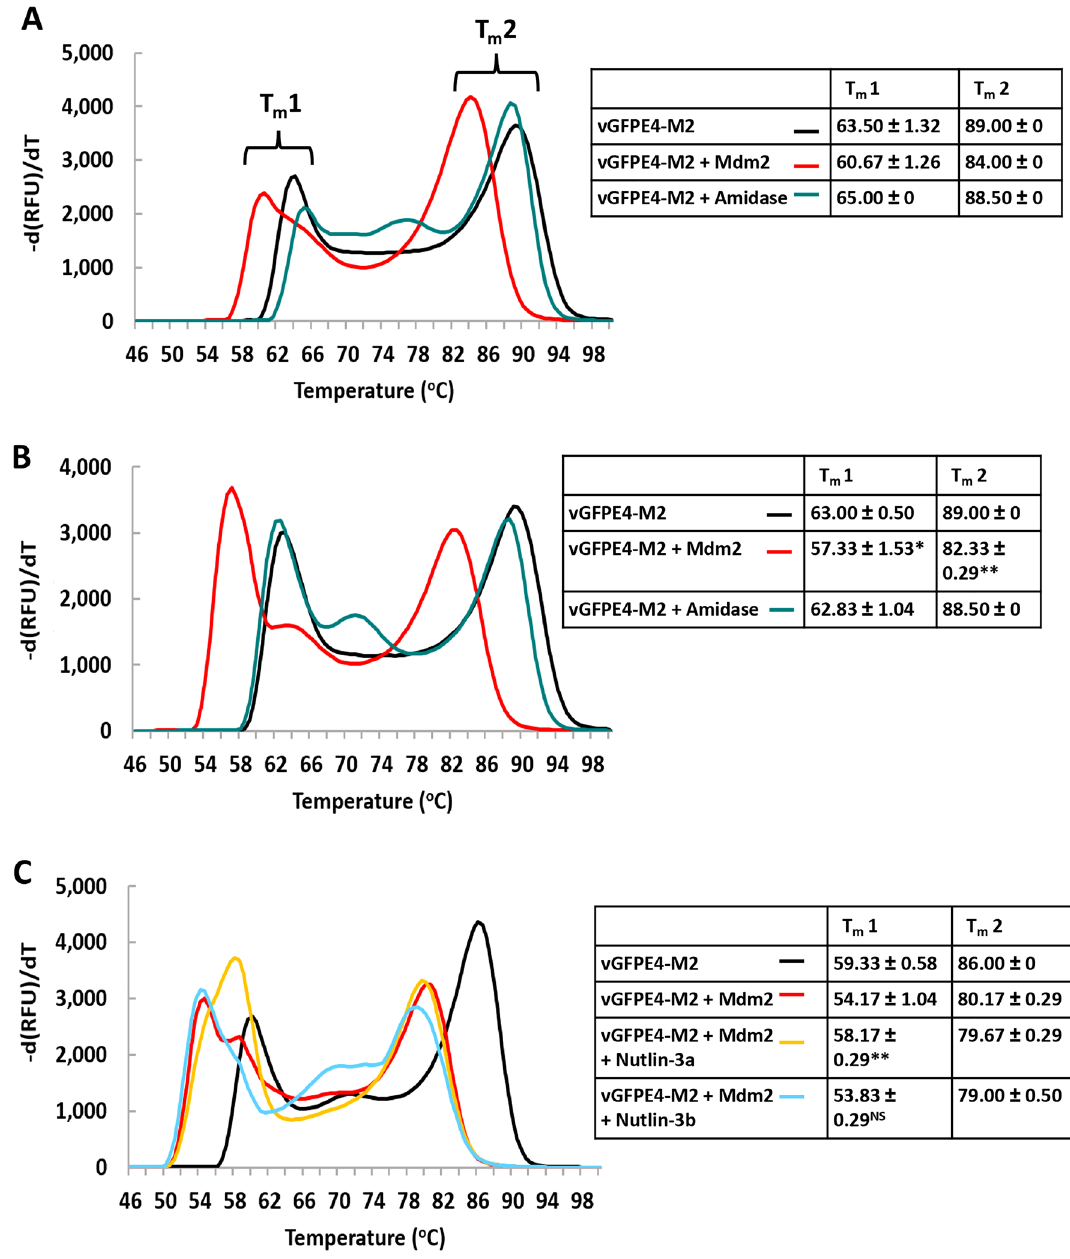
Figure 4. Specific detection of Mdm2 by vGFPE4-M2. ( A ) Melt curve analysis of vGFPE4-M2 alone (10 µM) or in the presence of specific (Mdm2) and non-specific (amidase) binders (100 µM). n = 3 ± SD. ( B ) Same as in A with addition of DMSO (10% v/v) in reaction mix. *p < 0.005 compared to T m 1 of vGFPE4-M2 alone. **p < 0.0001 compared to T m 2 of vGFPE4-M2 alone (Student’s t-test). ( C ) Melt curve analysis of vGFPE4-M2 (10 µM) in the presence of Mdm2 (100 µM) and specific (Nutlin 3a) and control (Nutlin 3b) small molecule competitors (1 mM). **p < 0.005 compared to T m 1 of vGFPE4-M2 + Mdm2 and vGFPE4-M2 + Mdm2 + Nutlin 3b. NS Not significant compared to T m 1 of vGFPE4 + Mdm2 (Student’s